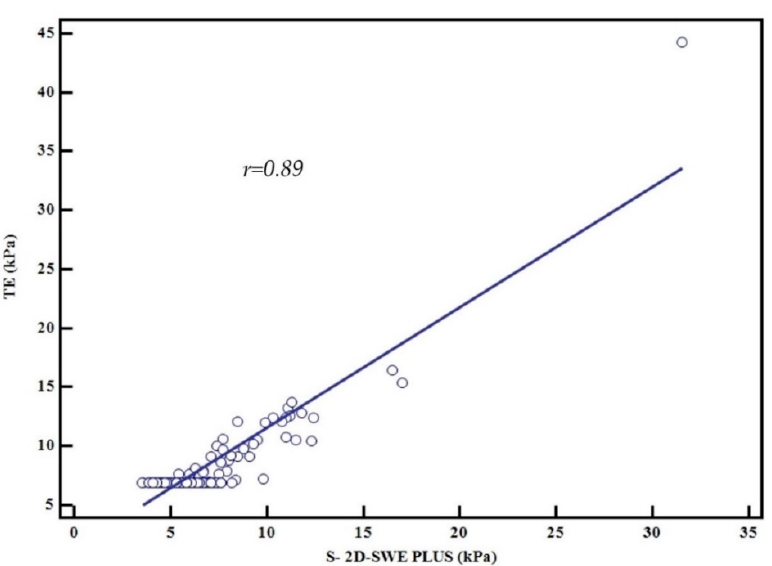
Figure 3. Relationship between the mean values assessed by TE and 2D-SWE.PLUS, Pearson’s correlation coefficient, r = 0.89.